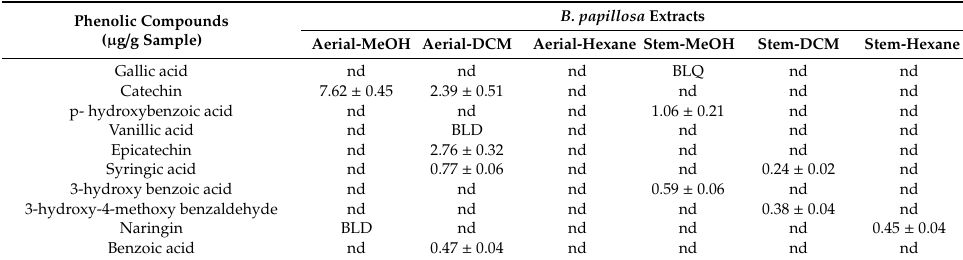
Table 1. HPLC phenolic quantification of Buxus papillosa